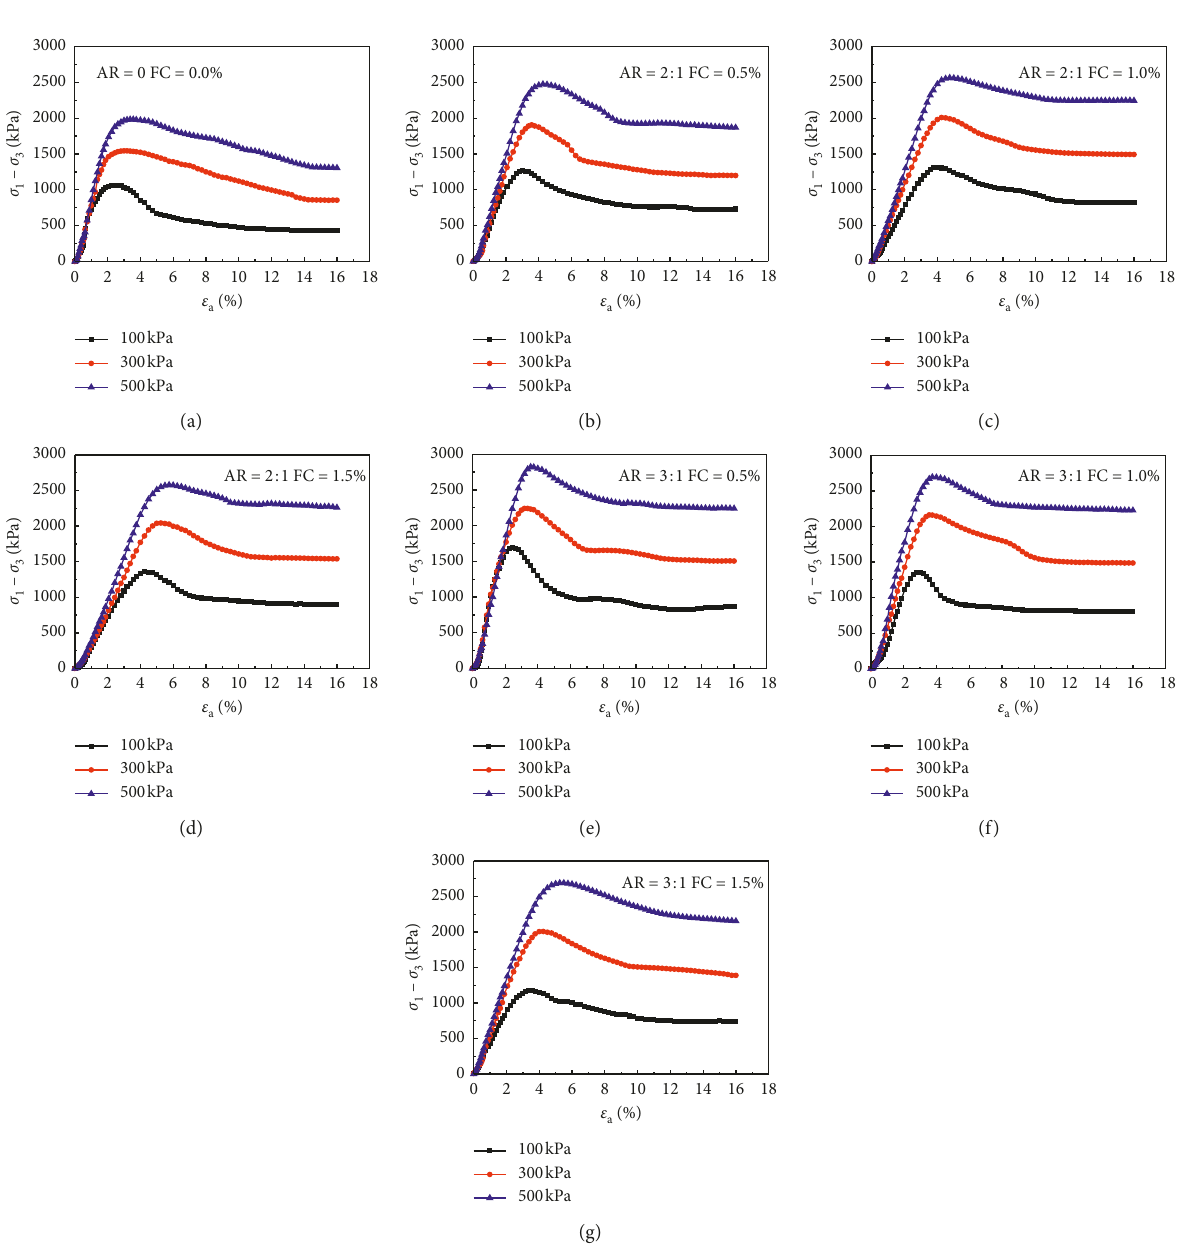
Figure 2: Stress-strain curves of triaxial